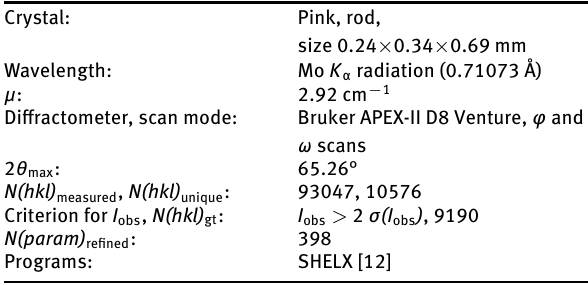
Table 2: Fractional atomic coordinates and isotropic or